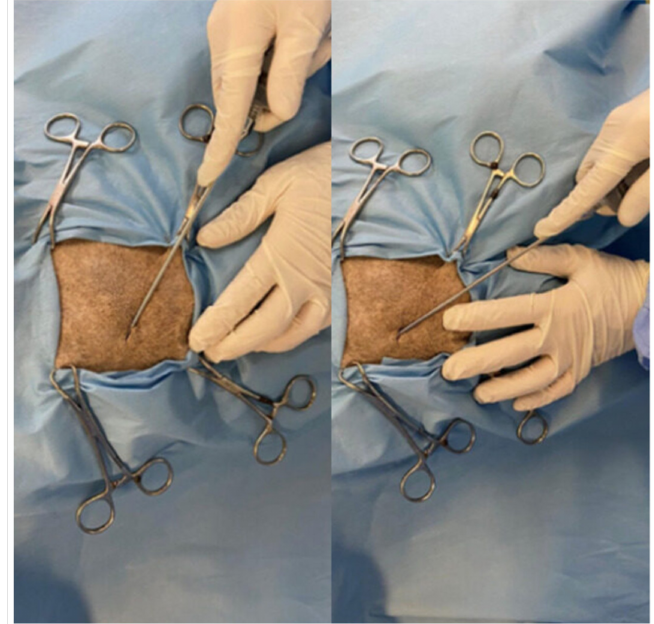
Figure 2. Adipose tissue sampling from the lumbar